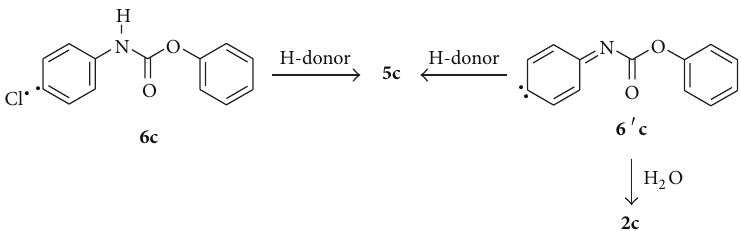
Figure 5: Irradiation of compounds 1c and 1d .